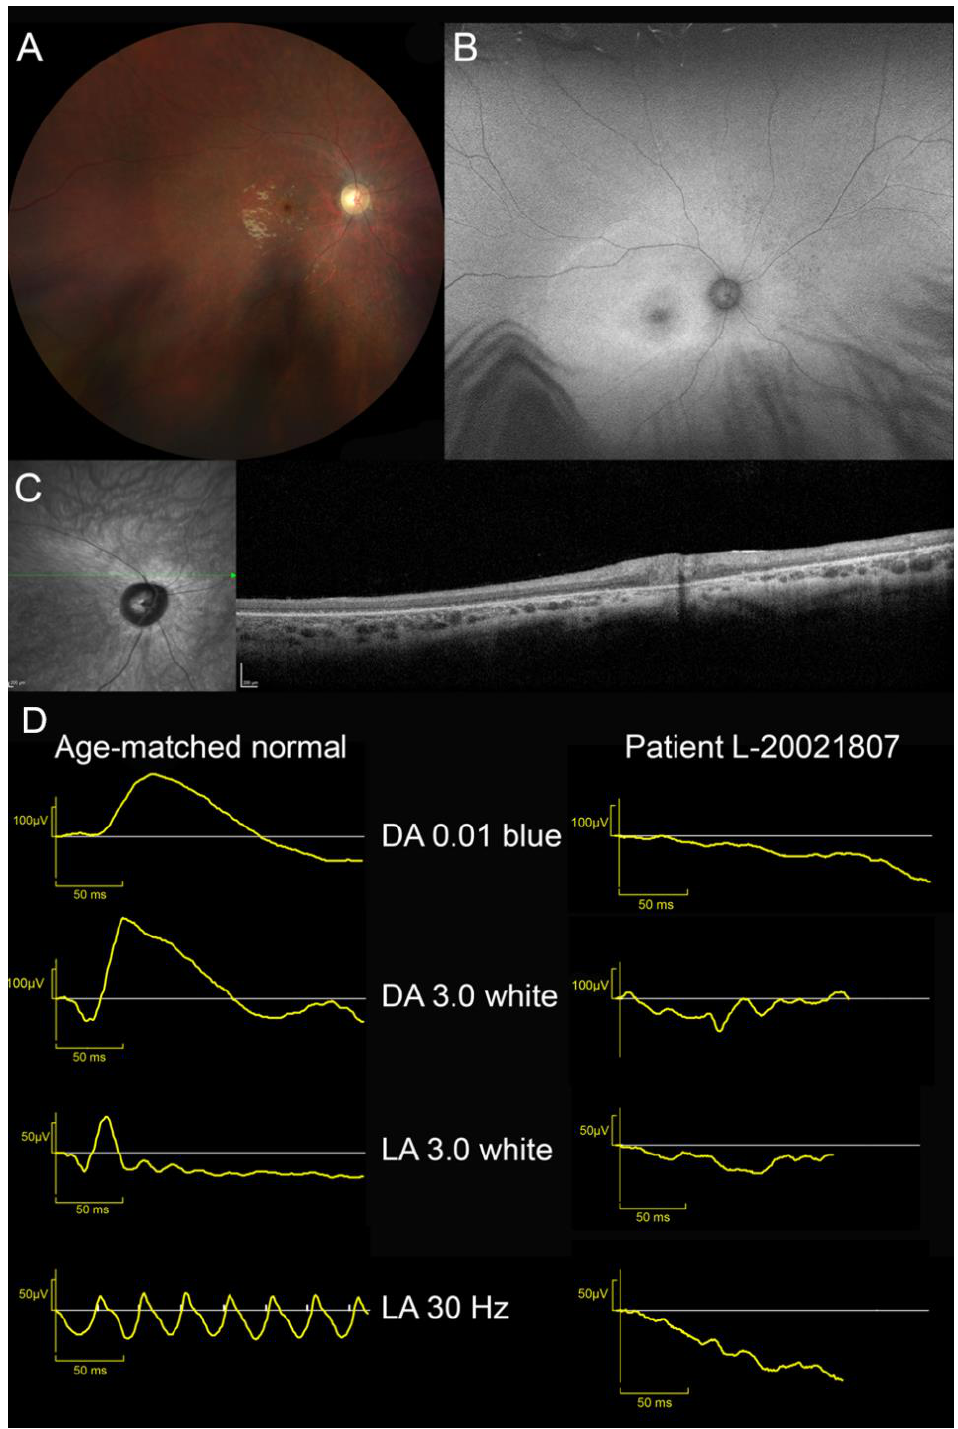
Figure 2. Ocular findings in patient with late-infantile neuronal ceroid lipofuscinosis (MFSD8- LINCL). ( A ) Waxy pallor of optic disc, severe vascular attenuation and whitish, depigmented appearance of posterior pole and midperipheral retina. Cellophane light reflex from the macula. ( B ) SW-FAF showed a large area of increased autofluorescence with indistinct border in the posterior pole and the second more narrow annulus of increased autofluorescence around the fovea. Fovea was irregularly hypoautofluorescent. Peripheral retina was isoautofluorescent. ( C ) SD-OCT. Retina was thin with indistinct lamination and widespread disappearance of outer layers (ONL, EZ and RPE). ( D ) ffERG. Unrecordable responses under dark- and light-adapted